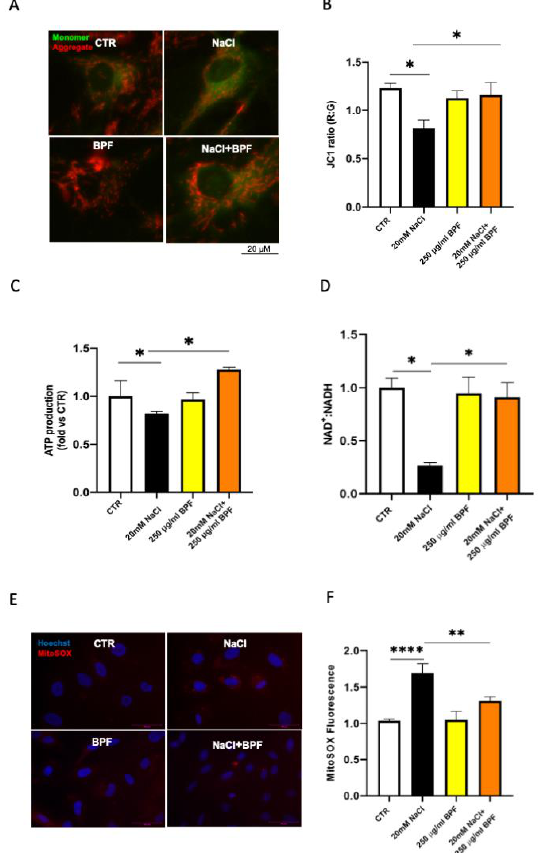
Figure 4. BPF exerts beneficial effect on mitochondrial function in SHRSP cerebral ECs exposed to high salt load. Fluorescence microscope analysis of mitochondrial membrane potential ( ∆Ψ m) levels through JC1 dye; representative images ( A ) and corresponding quantification ( B ) are shown. ( C ) ATP levels, ( D ) NAD + :NADH ratio (as a measure of Complex I activity), ( E , F ) mitochondrial ROS production detected by MitoSOX fluorescence and its graphical quantification. CTR indicates nontreated cells. N = 3–4. * p < 0.05, ** p < 0.01 and **** p < 0.0001 obtained using one-way ANOVA followed by Bonferroni post hoc analysis. Data are reported as mean ± SEM.